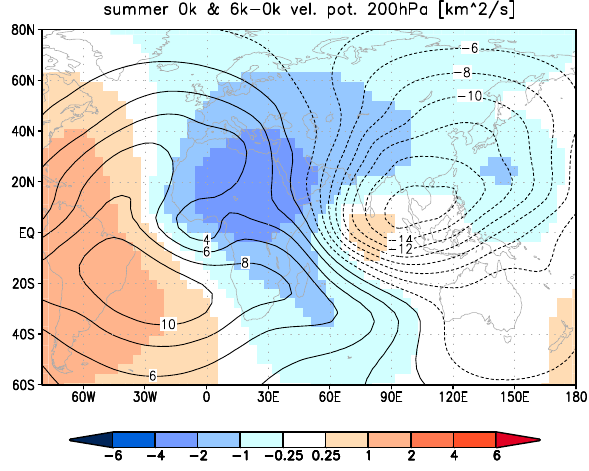
Fig. 10. Upper-tropospheric velocity-potential (200hpa, [km 2 /s]) as simulated by the atmosphere-only model, averaged over the summer season. Contour lines illustrate the velocity-potential under present-day orbital configuration. Shaded areas show the velocity-potential anomalies between 6k and 0k. Negative values represent divergence, positive values